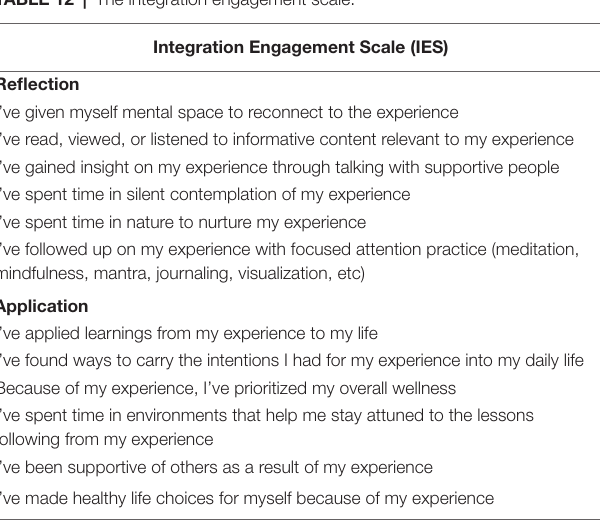
TABLE 14 | Summary of scale